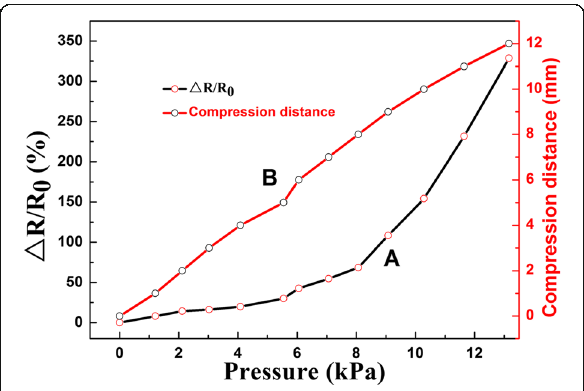
Fig. 6 A Pressure-response curve of the PANI/sponge sensor and B the corresponding relationship curve of pressure and compression